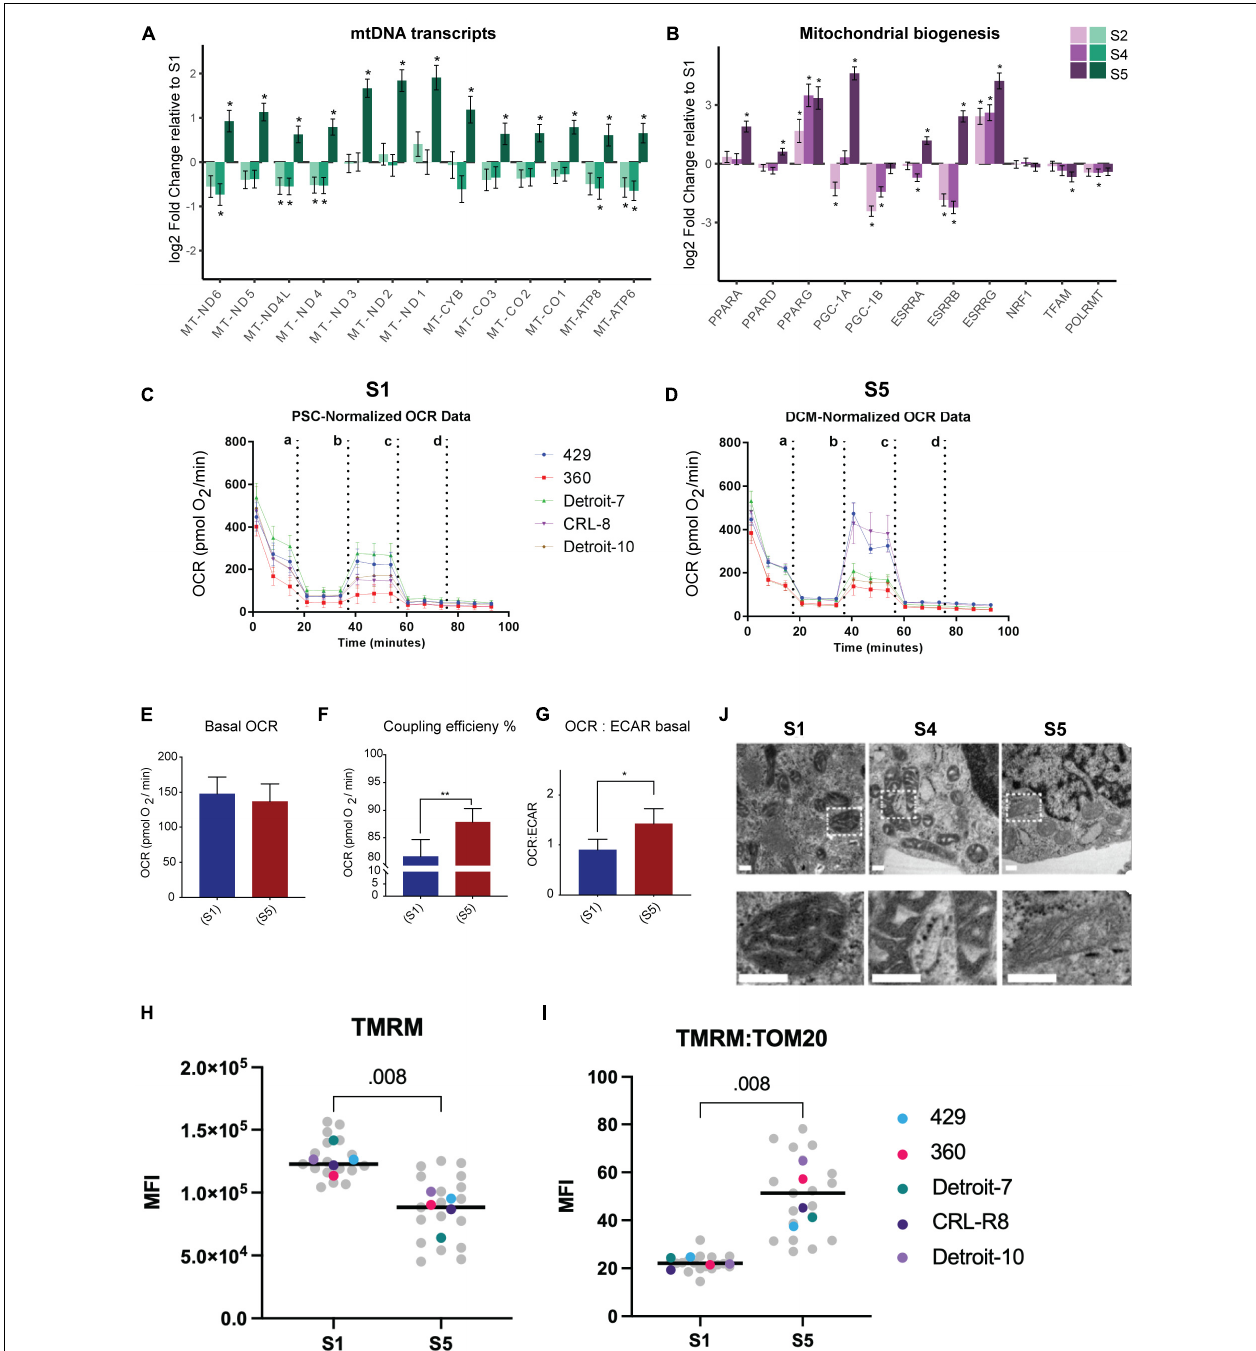
FIGURE 3 | Higher mitochondrial respiration in differentiated mesodermal derivatives despite lower mitochondrial content. (A) The mtDNA transcripts collected via RNA-seq (Dataset B) at different stages of mesoderm differentiation suggest a significant increase in the number of mitochondrial transcripts in S5 relative to S1. (B) A panel of genes associated with metabolic remodeling was selected based on previous studies (Scarpulla et al., 2012; Zheng et al., 2016) to evaluate changes in gene expression at different stages of mesoderm differentiation relative to undifferentiated, stage S1 cells. Bar plots depict the estimated log twofold change ± s.e.m, n = 5. (C,D) Graphs present the result of OCR in hPSCs (C) and differentiated cells at S5 (D) . Cells were exposed sequentially to oligomycin (a), CCCP (b), rotenone (c), and antimycin A (d). (E) To better visualize the result of Seahorse, we presented data as bar charts. Basal OCR level did not change in differentiated cells relative to undifferentiated hPSCs, which suggests higher rates of oxygen consumption by differentiated cells since we have shown that these cells have almost 50% less mitochondria compared with hPSCs. (F) Coupling efficiency increased significantly in differentiated cells, which showed a higher potential for ATP generation relative to undifferentiated hPSCs. (G) The basal OCR:ECAR ratio showed an increase in differentiated cells, confirming that these cells are more